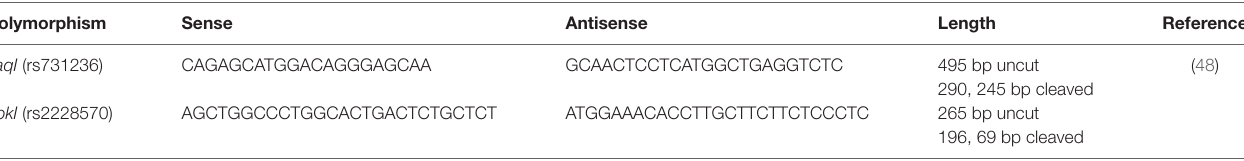
TaBle 1 | Sequences of primers used to amplify each polymorphism and their respective fragments with or without endonucleases. Polymorphism sense antisense length